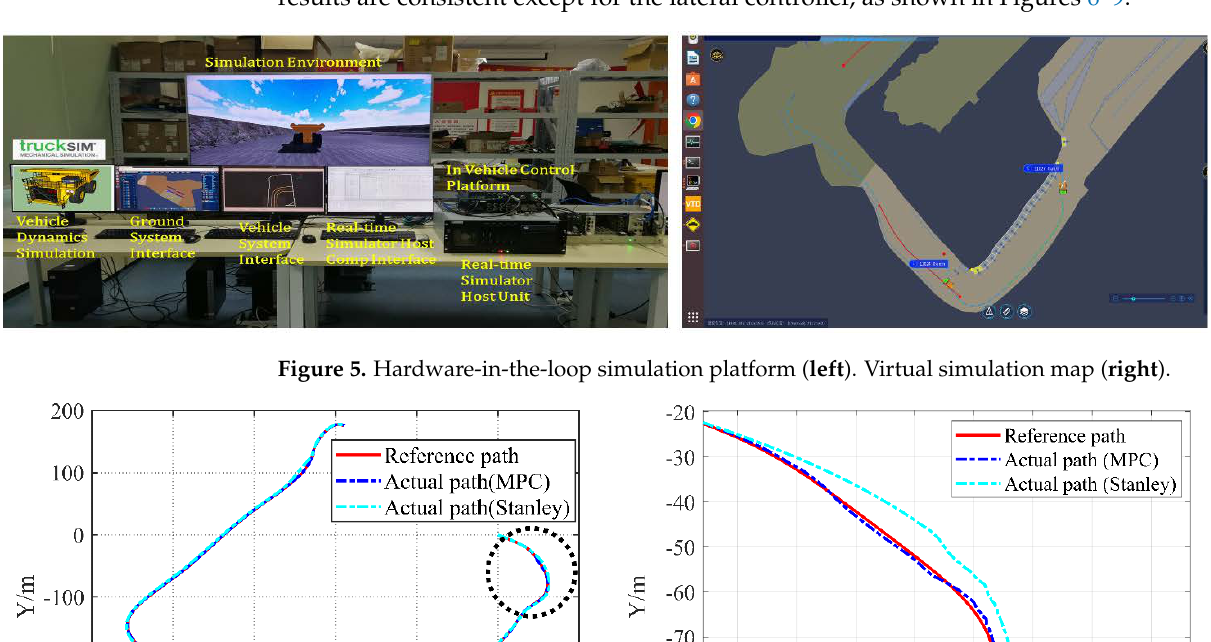
Figure 7. Heading angel deviation of MPC control and Stanley control. Figure 8. Vehicle wheel angle of MPC control and Stanley control ( left ). Control stability compari- son ( right ). 0